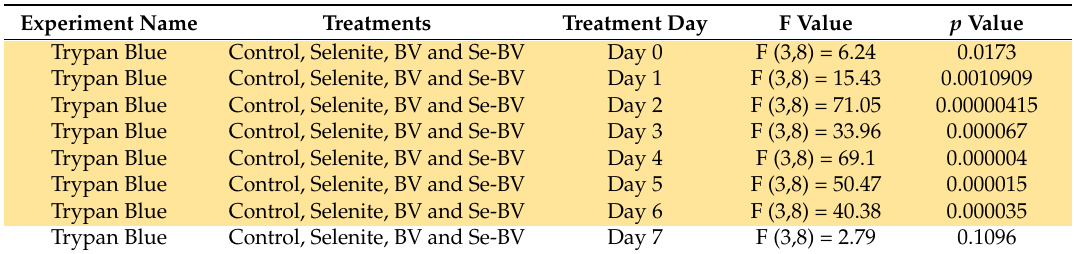
Table 4. ANOVA Results for Cell Viability with Se-BV Treatment for MDA-MB-468 Cells.